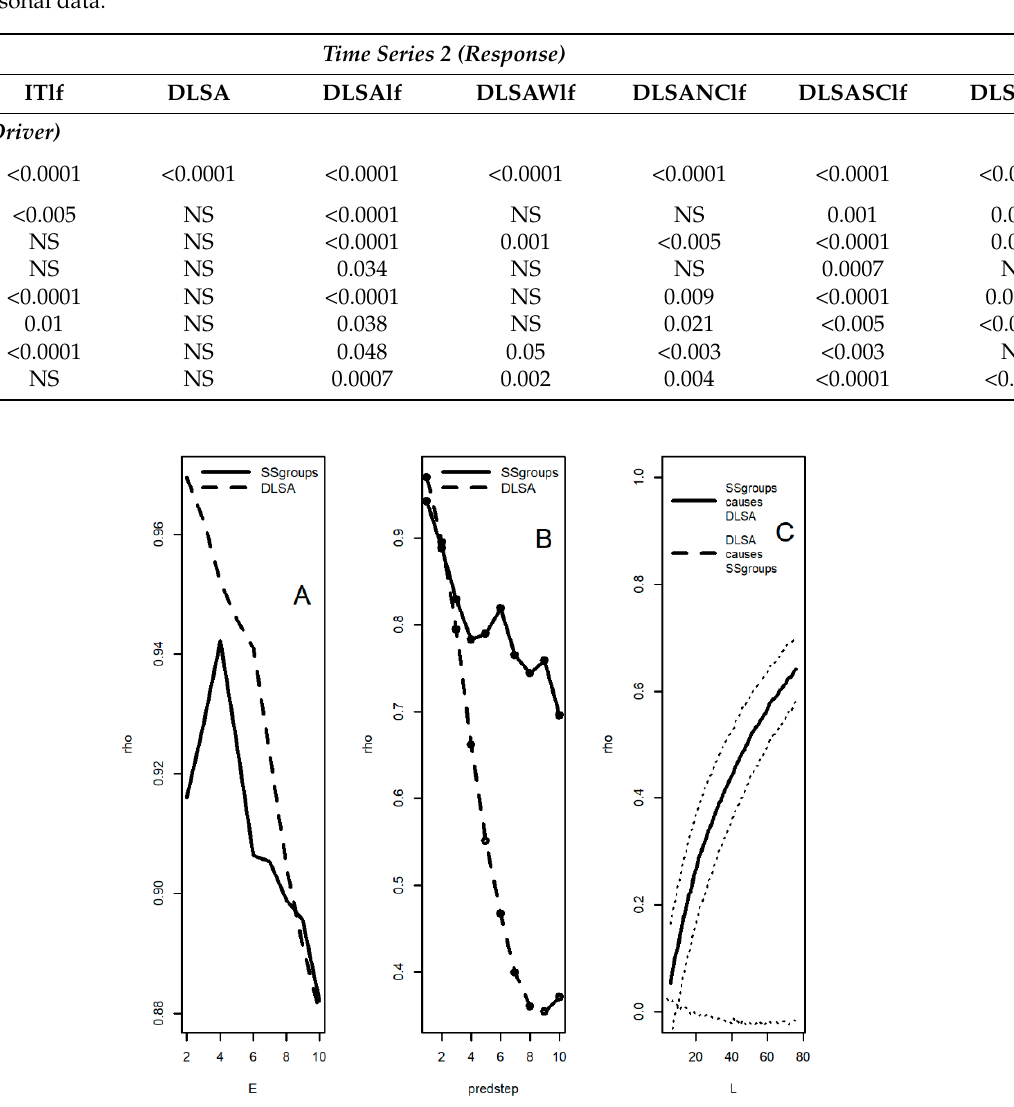
Table 4. Results of analyses using CCM tests of causality of various time series (drivers) causing the low frequency inferred Desert Locust series 1866–2014 (ITlf) and the gridded Desert Locust series (1930–2014). p values given if relationships statistically significant (NS = not significant). Note that the results for the unfiltered sunspot groups data (1866–2010) reveals significance for all relationships with the gridded Desert Locust data. DLSA = 1 ◦ gridded data (1930–2014); DLSAlf = low frequency component of DLSA, followed by the same for regional data (W = West; NC = North Central; SC = South Central; E = East). SOI = Southern Oscillation Index; NAO = North Atlantic Oscillation; NAOlf = low frequency component of NAO, followed by seasonal data.